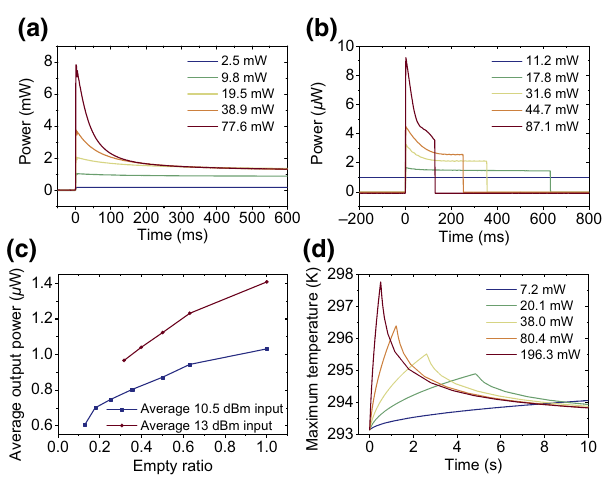
FIG. 3. (a) Experimental output response of the power limiter at different input optical powers. A 101.6 mm prism is used with a 750 μ m diaphragm. The power limiting effect has a long set- tling time of around 300 ms. (b) Experimental output response of the power limiter with constant-energy pulse input. A 101.6 mm prism is used with a 25 μ m diaphragm. The peak power and duty cycle are selected to maintain the same energy per pulse or the same average input power of 10.5 dBm. (c) The average output power at different duty cycles with average input powers of 10.5 and 13 dBm shows that the maximum output power occurs at a duty cycle of 1, i.e., CW input. (d) The COMSOL simulated max- imum temperature inside the prism with constant pulse energy of 97.8 mJ and pulse widths of about 0.5 to 13.5 s, which corre- spond to an average input power of 9.78 mW in a 10 s time